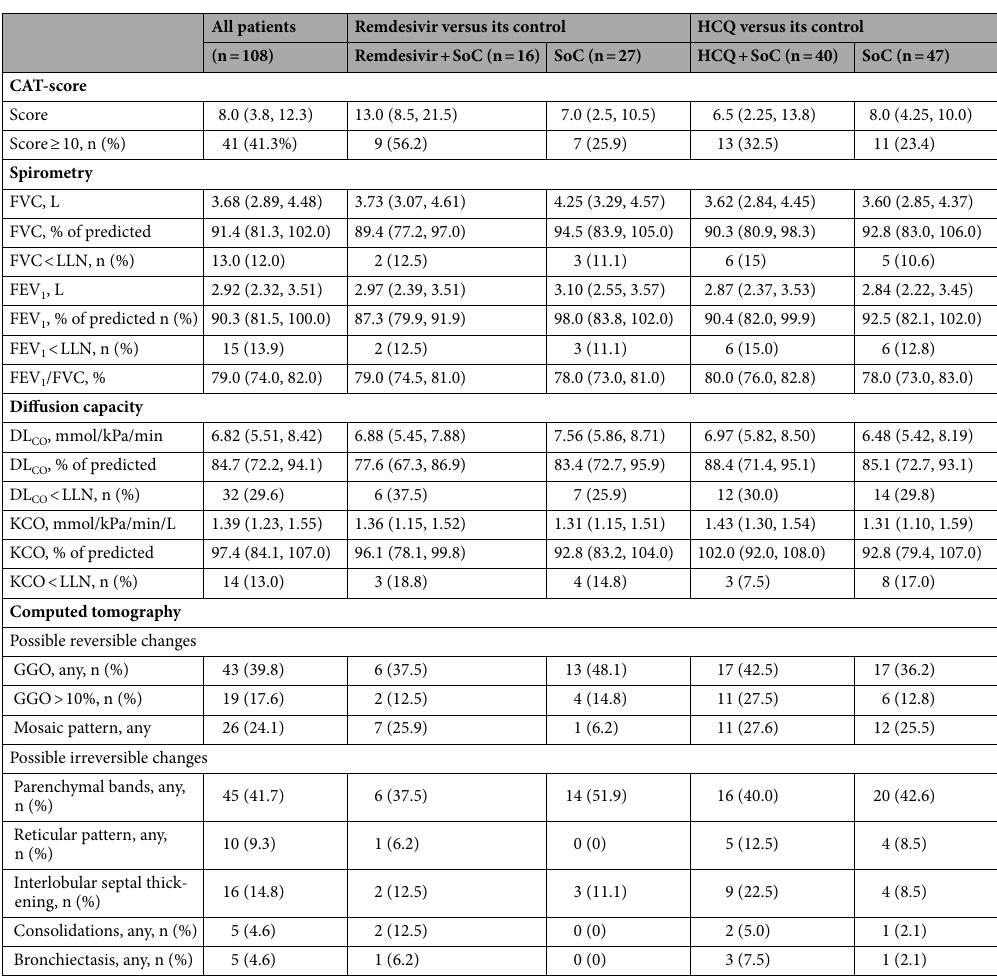
Table 2. Presentation of lung function and CT findings 3 months after treatment for COVID-19. Median (25th–75th percentile) unless otherwise specified. HCQ hydroxychloroquine, SoC standard of care, FVC forced vital capacity, LLN lower limit of normal, FEV 1 forced expiratory volume in the 1st second, DL CO diffusion capacity of the lungs for carbon monoxide, KCO transfer coefficient of the lungs for carbon monoxide, CAT- score the COPD assessment test, GGO ground-glass opacities. GGO ≥ 10% in ≥ one lung